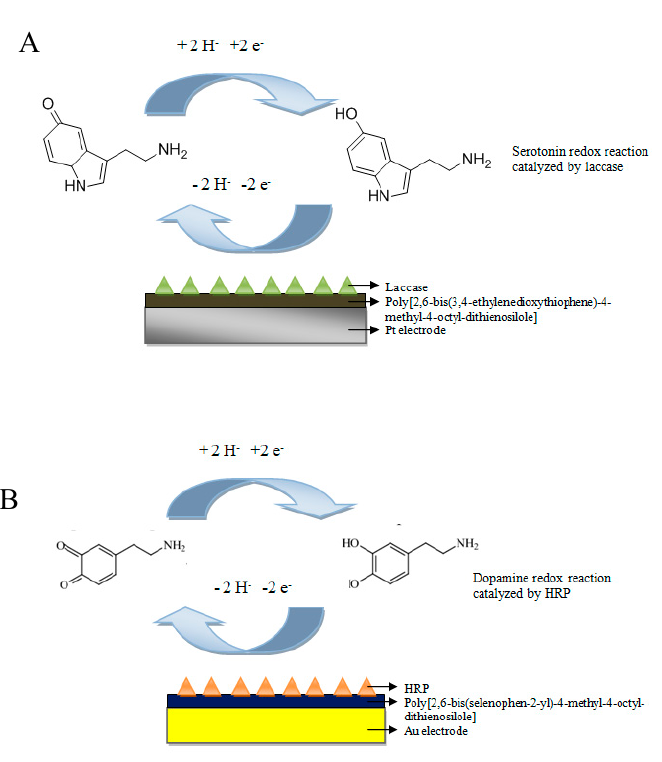
Figure 8. Schematic redox reaction catalyzed by oxidoreductases: ( A ) proposed detection system for serotonin (5-HT) determination and ( B ) detection system for dopamine (DA) determination.